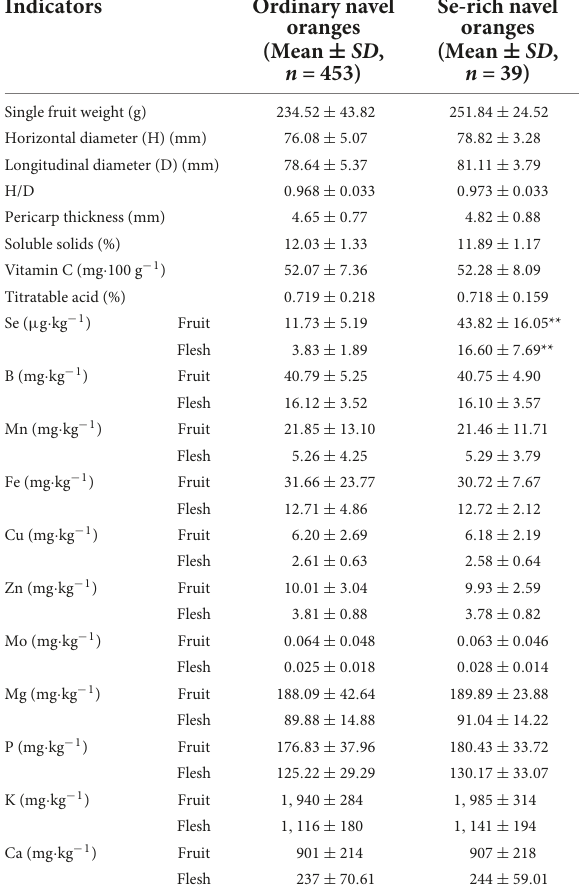
TABLE 1 Quality indicators and mineral elements of ordinary navel orange (total Se < 10 µ g · kg − 1 in the flesh) and Se-rich navel orange (total Se ≥ 10 µ g · kg − 1 in the flesh) fruit (** p <